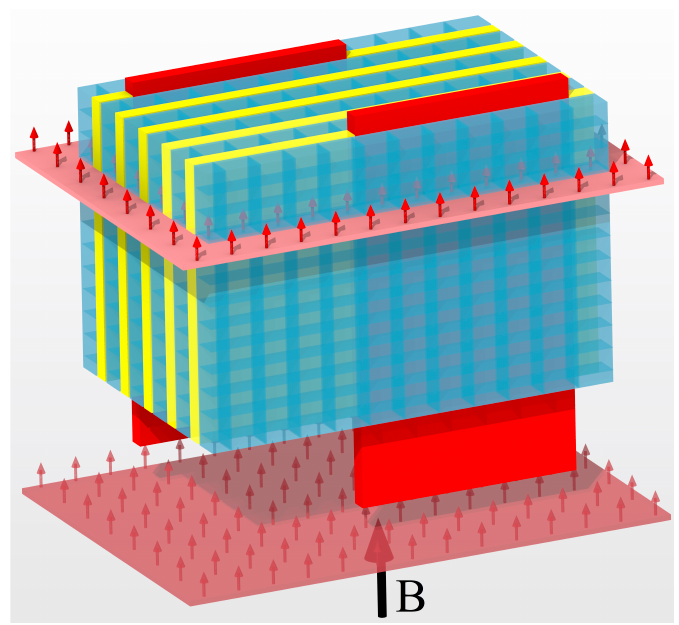
Figure 2. Color online, from [3]. Cartoon of the FFLO state showing the nodes in the order parameter as horizontal planes where we estimate the spin-polarization to be ≈ 10% at 25 T in the low temperature limit. In the diagram the black arrow labeled B represents the applied magnetic field, and the red arrows represent the net spin polarization. Although the diagram is schematic, all of the lengths are to scale; small boxes represent the unit cells of κ ET-CuNCS, yellow slabs represent the least conducting layers of the crystal, and red rectangles represent Josephson core-less vortices at about the right distance apart in a 25 T field. The full height of the crystal is ≈ 20